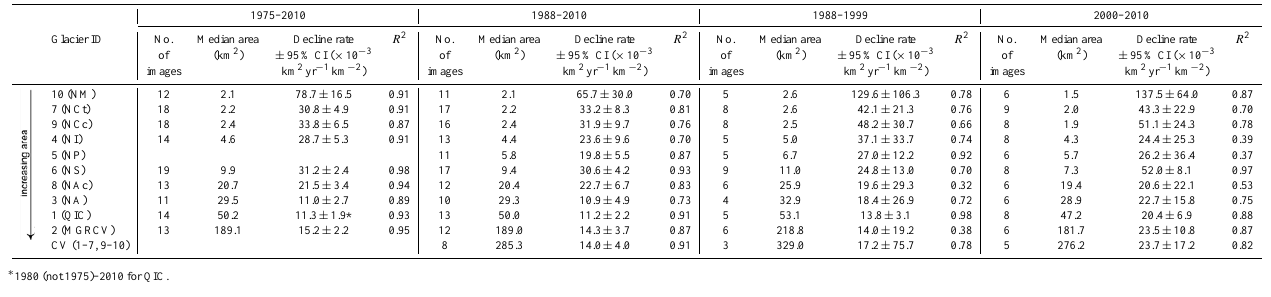
Table 3: Normalized (against median area) glacial decline rates using minimum areas for 2 each year for each glacierized ID throughout the Cordillera Vilcanota (IDs 1-7, 9-10) and just 3 beyond (ID 8) for four different time periods: 1975-2010 (the whole time series, including 4 Regression using minimum areas: (1988-2010) Corona and MSS imagery), 1988-2010 (the densest time series, Landsat TM/ETM+ and 5 Glacial area = X * -0.01181 + 8938 r = 0.89, n = 7, RMSE = 43.68 km ASTER), 1988-1999 (which roughly represents the 1990s but with additional 1988 data 6 points to strengthen the regression), and 2000-2010 (the 2000s). CI is the Confidence Interval. 7 For full Glacial ID names, please refer to Figure 8. Note that decline rates are listed as 8 positive values. These same decline rates before normalization can be found in the 9 Supplementary Material (Table SM C1). 10 Landsat TM/ETM+: B3/B5 & B1 Minimum area for each year Fig. 11. Lake-area (blue) time series for Lake ID 8 (cf. Fig. 8) and Fig. 10. Glacial-area time series for the Cordillera Vilcanota glacial area (red) within its upstream catchment. This proglacial (Glacial IDs 1–7, 9–10 combined, Fig. 8) and decline rates for the lake downstream of Nevado Ausangate (Glacial ID 3) started to CV from both this study and Salzmann et al. (2013). We do not rapidly grow in the late 1990s and early 2000s. We do not show include data points from Salzmann et al. (2013) as our glacial ex- uncertainties in the glacial areas to avoid cluttering the figure, but tents are not the same. However, we include decline rates derived these are on the order of ∼ from their study and our decline rates to show general comparisons, although these are non-normalized, and therefore reflect different areal extents. Note that because these are decline rates, they are listed as positive values. Hence, a negative value indicates advance- ment. Symbology and uncertainties are the same as for Fig. 9.